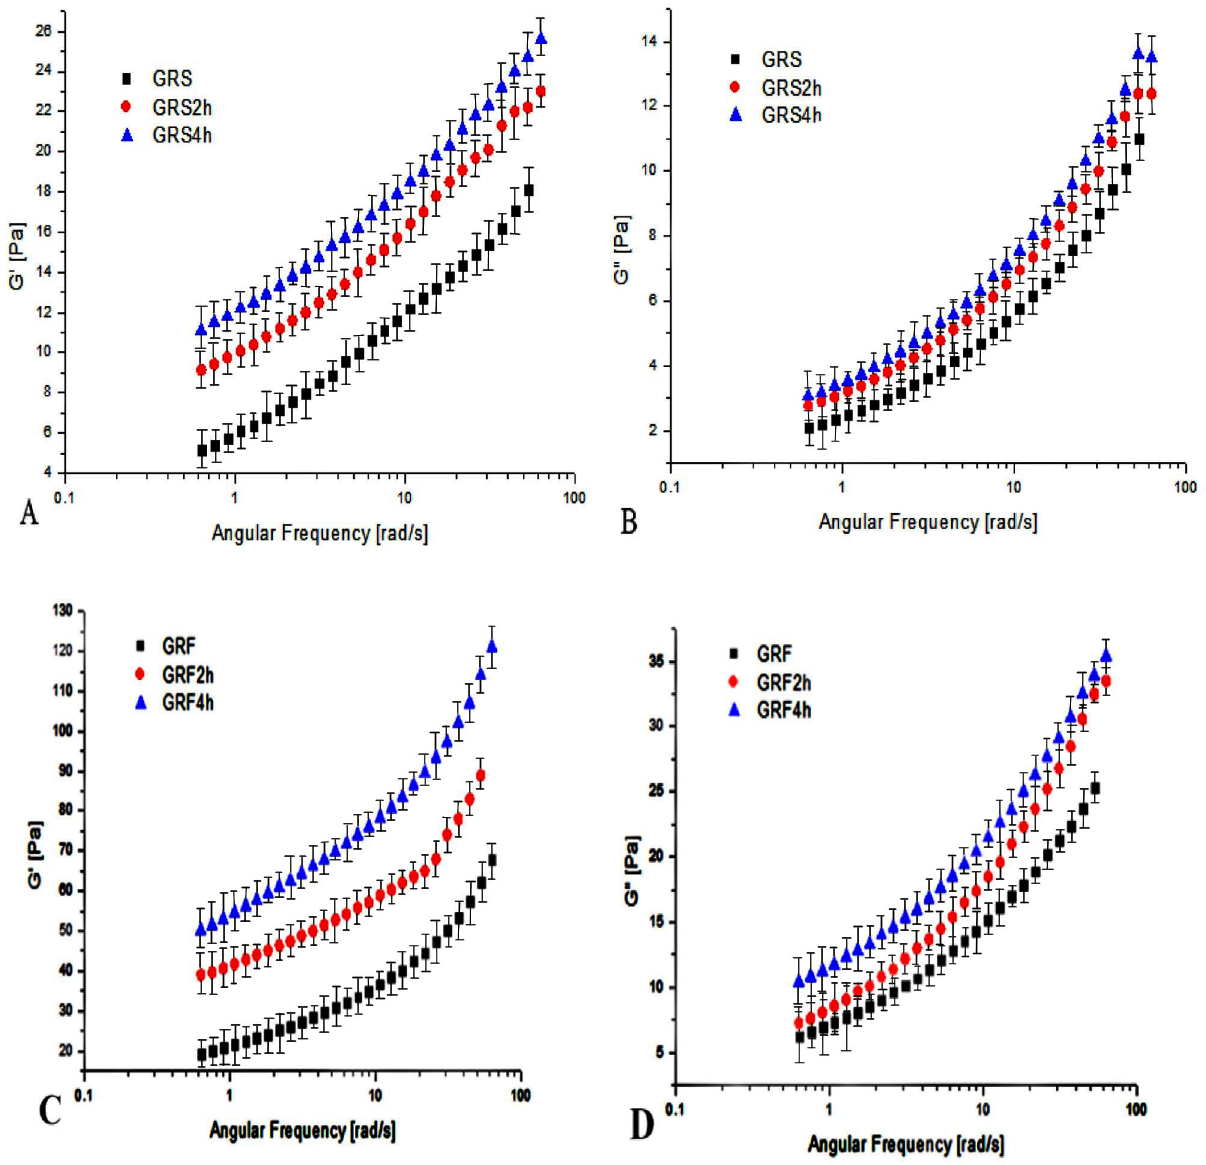
Fig 4. Storage modulus (G') and loss modulus (G") as a function of angular frequency for the GRS (A and B) and GRF (C and D) before and after dry heating. GRS2 h, 4 h: the glutinous rice starch (GRS) pastes after dry-heat treatment at 130°C for 2, 4 h; GRF2 h, 4 h: the glutinous rice flour (GRF) pastes after dry-heat treatment at 130°C for 2, 4 h. The data points represent the mean values of three samples and error bars show the standard